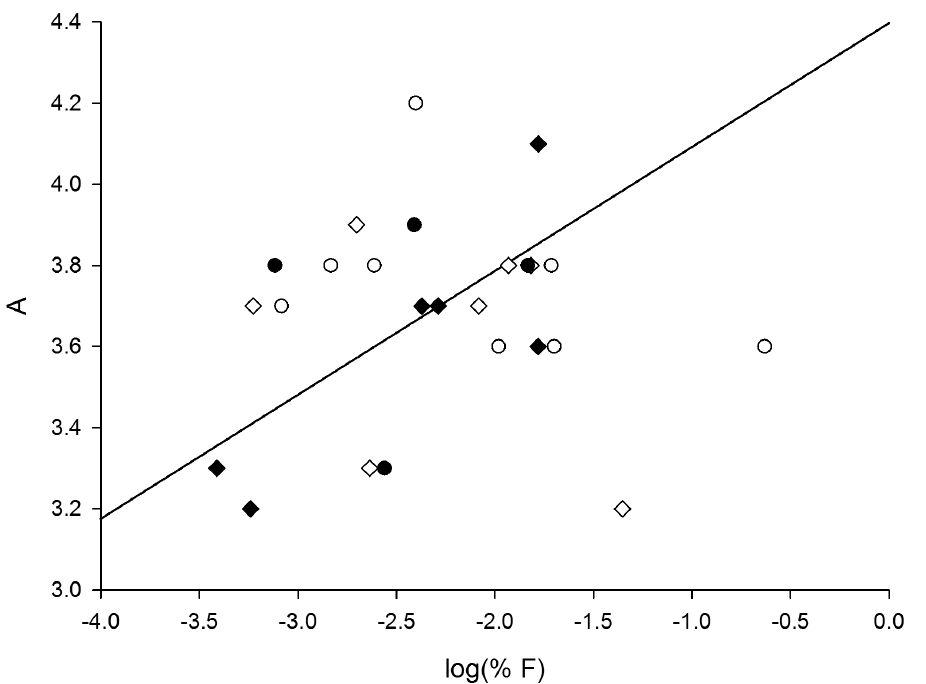
Figure 2. Relation between the mean number of alleles (A) and the percentage of female plants (%F). The relation is visualized independent for small ( , 500 plants, open symbol, no regression line shown) ( r =–0.29, P =0.29) and large populations ( . 1000 plants, full symbol, continuous line) ( r =0.64, P =0.048). Recent populations are presented as diamonds, old populations as circles. %F was log transformed.